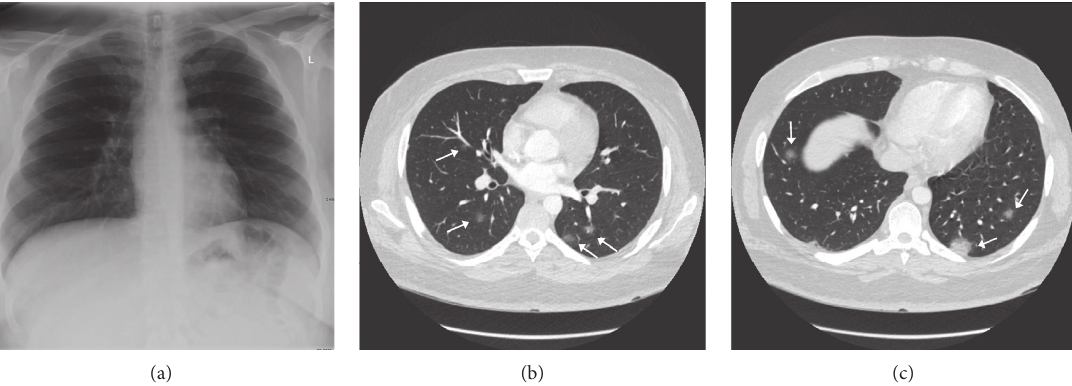
Figure 1: A 26-year-old male with a recent diagnosis of diabetes presented with several days of progressive myalgia, cough, chills, and dyspnea and intermittent generalized crampy mild abdominal pain. (a) The chest radiograph was negative for consolidation. (b, c) The CT pulmonary arteriogram was performed for the same patient to rule out pulmonary embolism and showed multiple patchy, lower-lobe- prominent, nodular ground-glass opacities (arrows). The patient was tested positive for COVID-19.